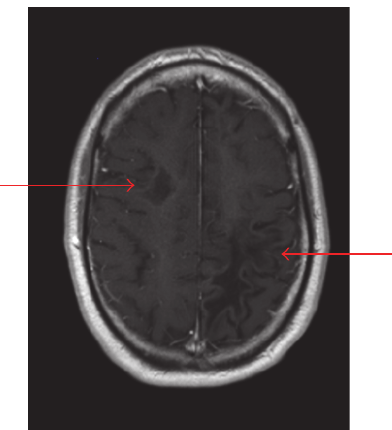
Figure 2: Interval improvement in enhancing white matter lesions consistent with clinical